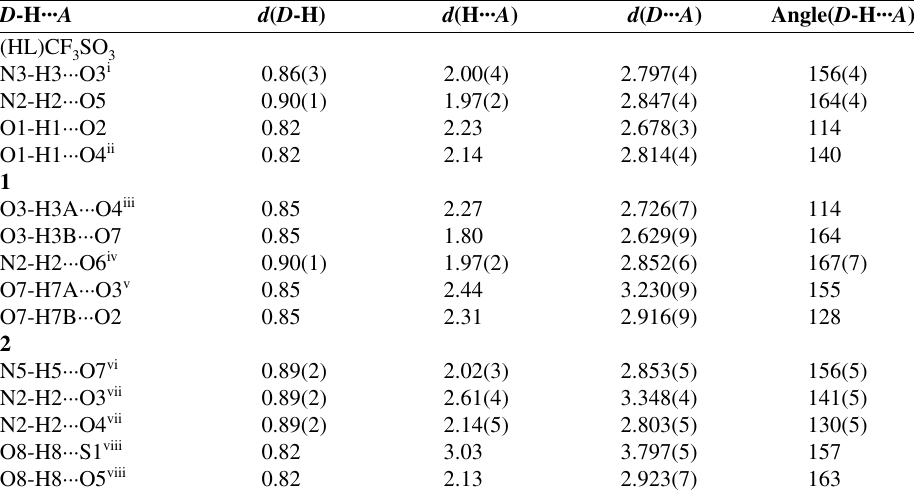
Table 3. Distances (Å) and angles (°) involving hydrogen bonding of the compounds D -H···